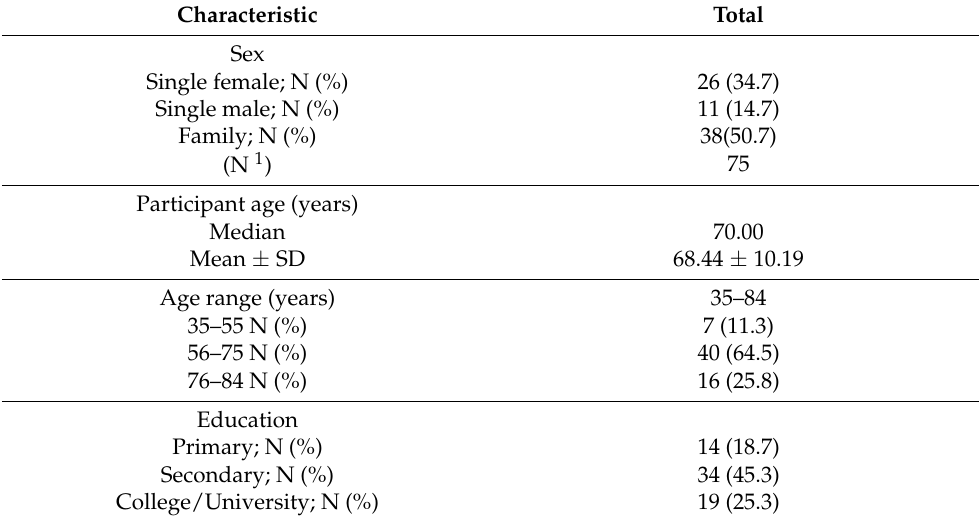
Table 1. Characteristics of the